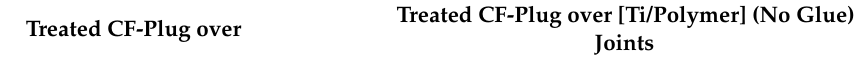
Table 3. Summary of improvements in normalized (corrected) values of UTS ( c σ b ) (MPa) for CF cross- section portions of joints calculated according to rule of mixtures in Table 2 for: treated (HLEBI or Ni plating) joints over untreated CF plug joints (left two columns); and total improvement of treated CF plug joints over Ti/polymer (no plug, no glue) joints (right two columns). Data is from: Hasegawa, Faudree, Matsumuara, Jimbo, and Nishi (2016) [10]; Hasegawa, Faudree, Enomoto, Takase, Kimura, Tonegawa, Jimbo, Salvia, and Nishi (2017) [11]; and Nishi, Uchida, Faudree, Kaneko, and Kimura (2019) [46], for titanium joints with ABS, PC, and epoxy,